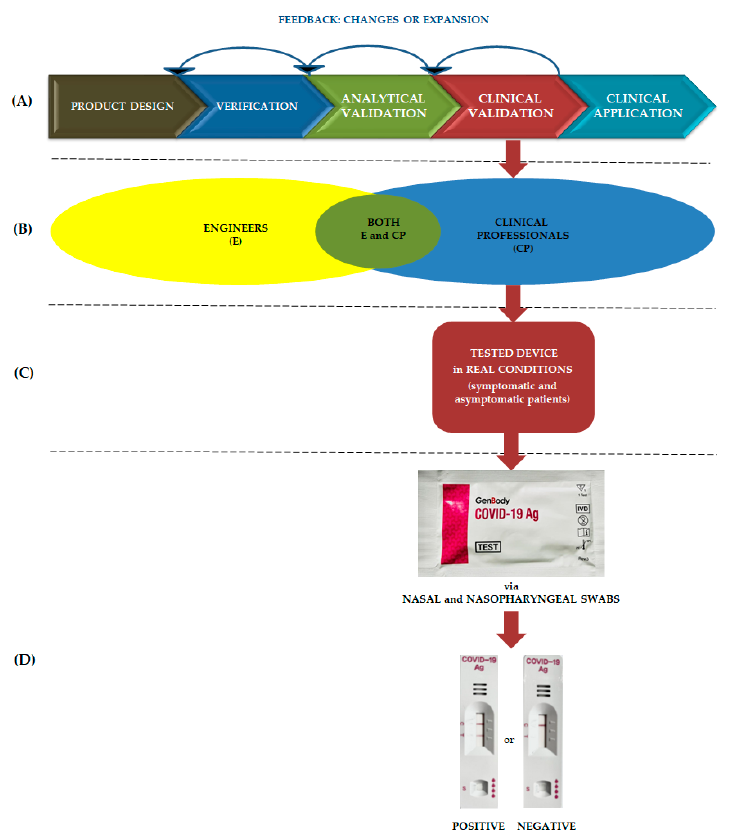
Figure 1. General view of the clinical trial: ( A ) stages including checkpoints, ( B ) role of various disciplinary experts, ( C ) device evaluation in clinical conditions, ( D ) tested medical device including visualization of positive and negative results.